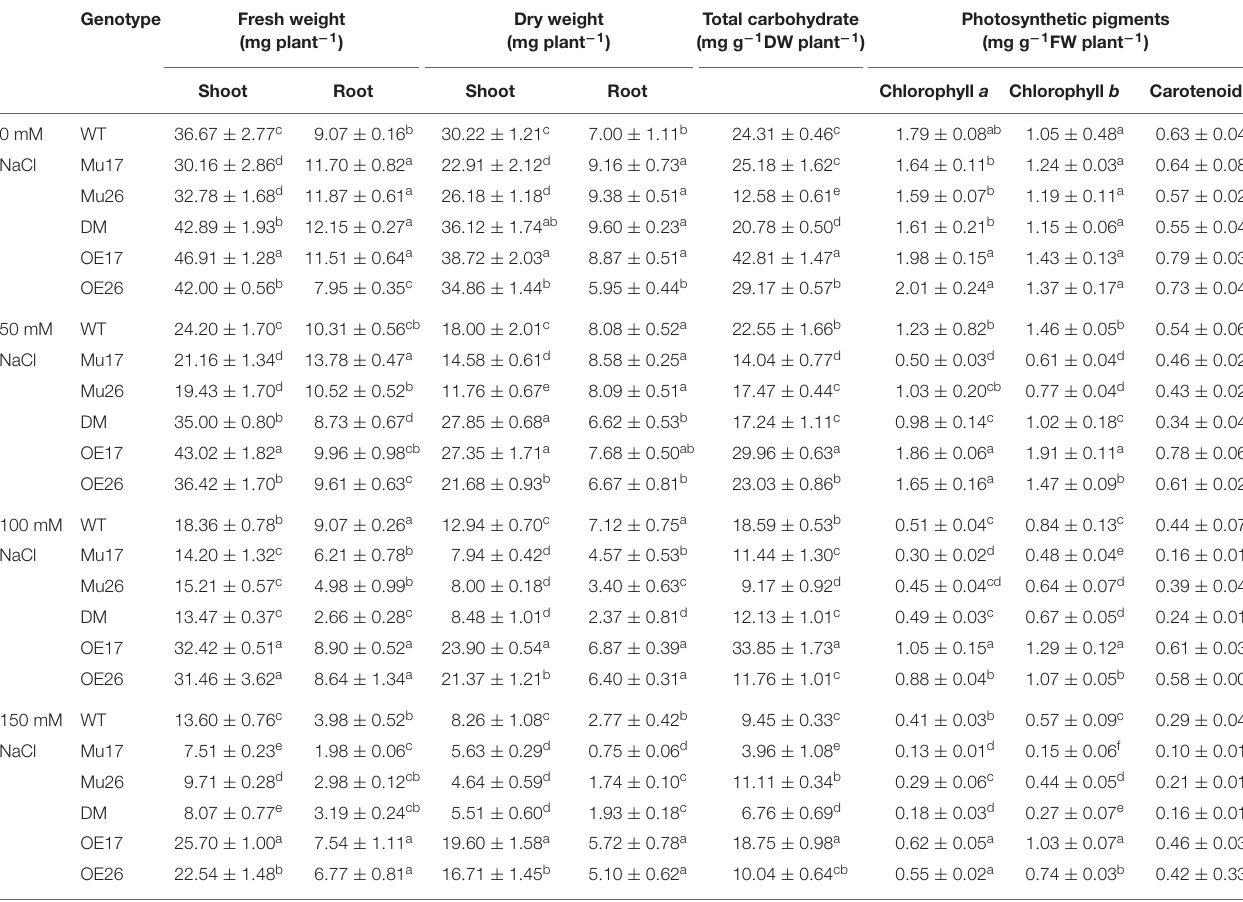
TABLE 2 | Means ( ± SE) of the fresh and dry weight, total carbohydrate, and photosynthetic pigments contents in genotypes subjected to NaCl concentrations. Genotype Fresh weight Dry weight Total carbohydrate Photosynthetic pigments (mg plant − 1